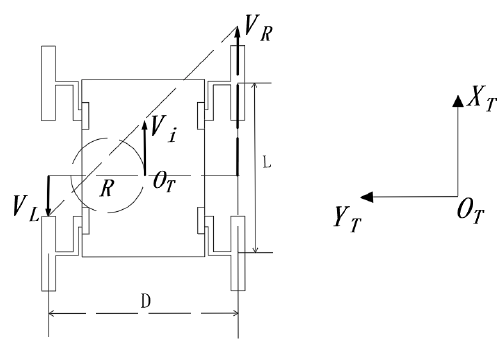
Figure 4. Small radius turning process.